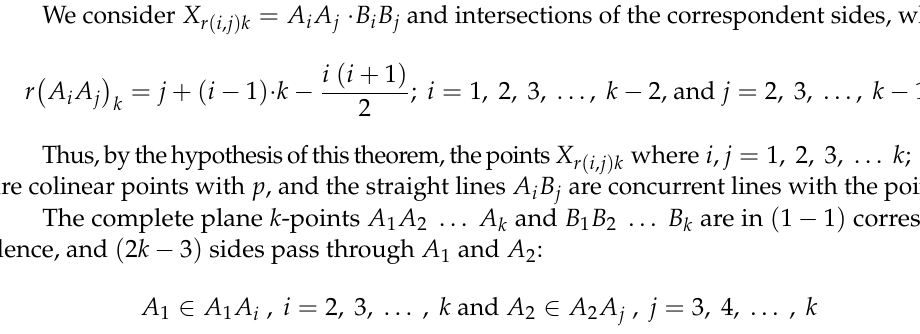
Figure 3. Perspectivity of two complete n -points from a line.